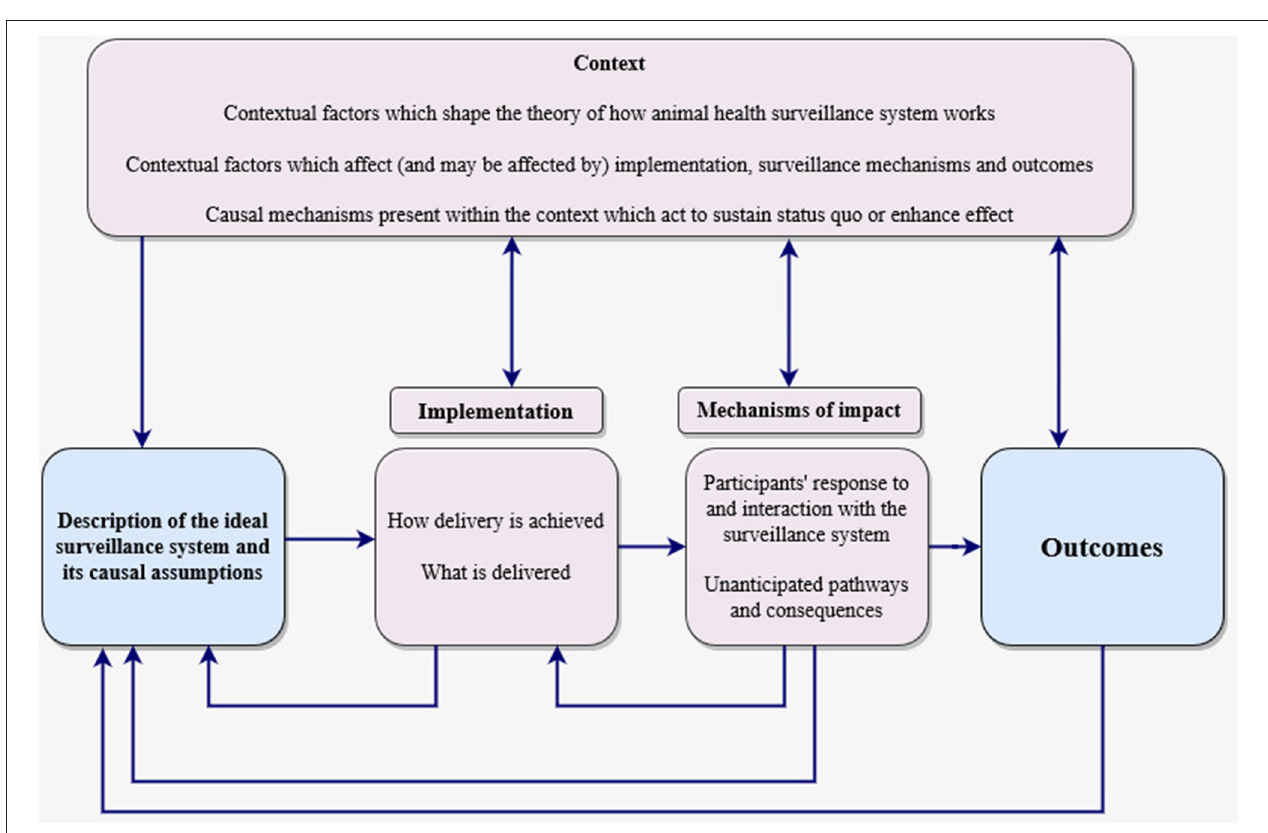
FIGURE 3 | Process evaluation framework adapted from Moore et al. (15) (amour colored boxes are the key components of a process evaluation. Investigation of these components is shaped by a clear description of the surveillance system which also informs interpretation of